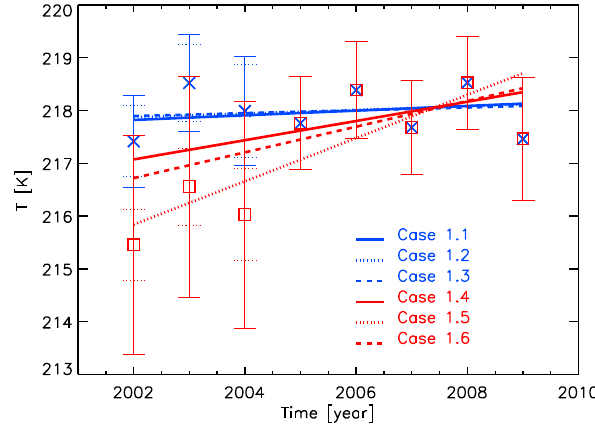
Fig. 1. Linear trends from MIPAS annual mean temperatures at 25km altitude, 30 ◦ S–30 ◦ N . Cases 1.1–1.3 are based on measure- ment data as they are, while an artificial bias of − 2K has been ap- plied to temperatures of the years 2002–2004 in cases 1.4–1.6. In cases 1.1 and 1.4 covariances were treated correctly; in cases